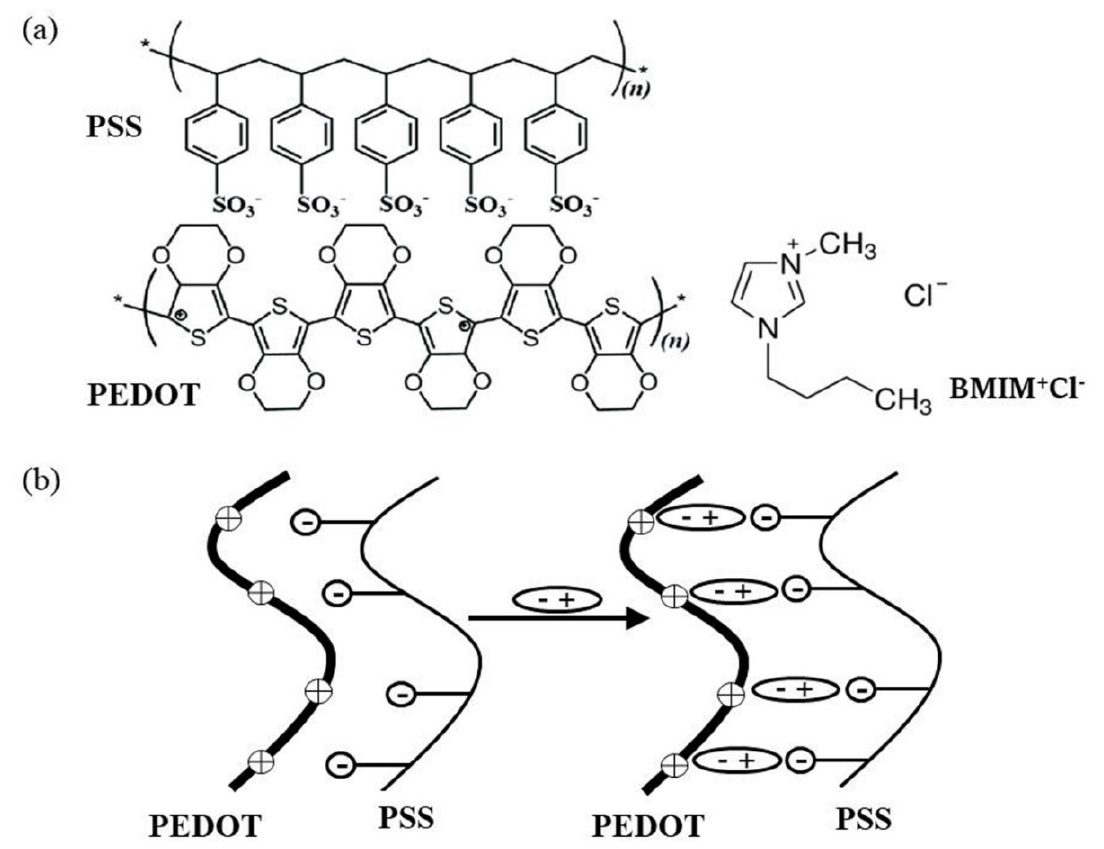
Figure 5. ( a ) Binding effect and ( b ) pushing effect when doping BMIM + Cl − into PEDOT:PSS